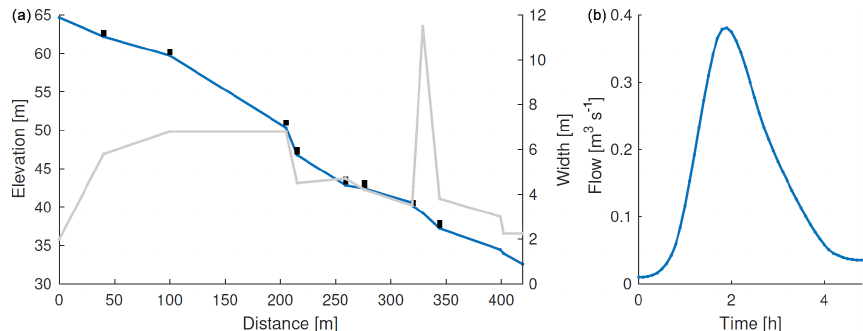
Figure 11. (a) Geometry of the Penny Gill network with given position of dams and widths labelled. (b) Inflow hydrograph based on ReFH approach described in the